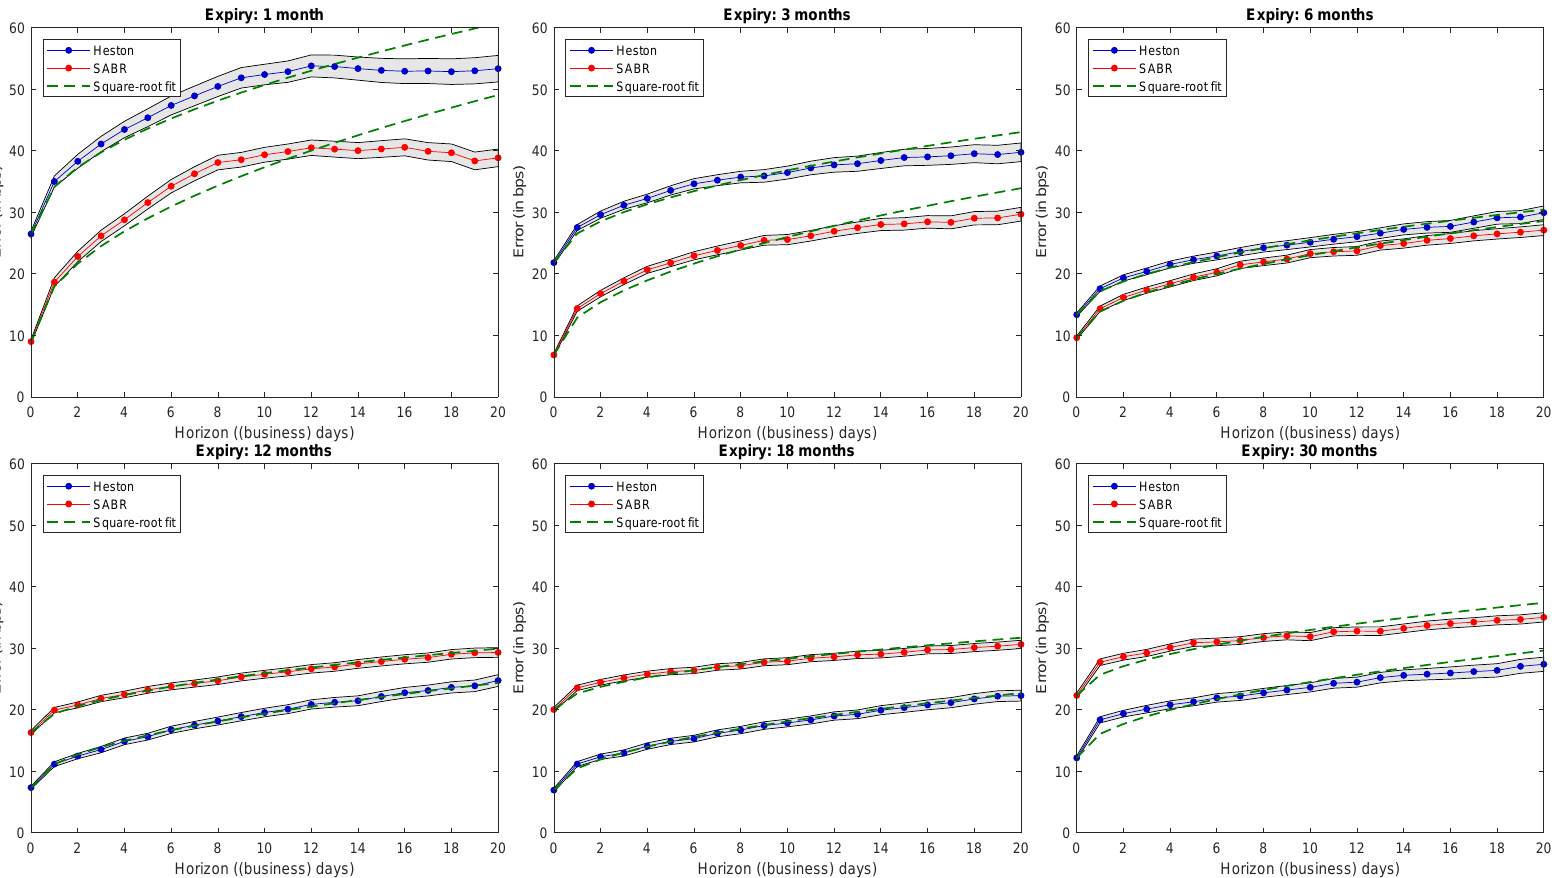
Figure 6. Model prediction quality. The graphs show average absolute errors at different horizons (x-axis) and for different expiries (panels). Blue is Heston and Red is SABR. The shaded areas are 95% confidence bands, the dotted green curves are the best-fitting